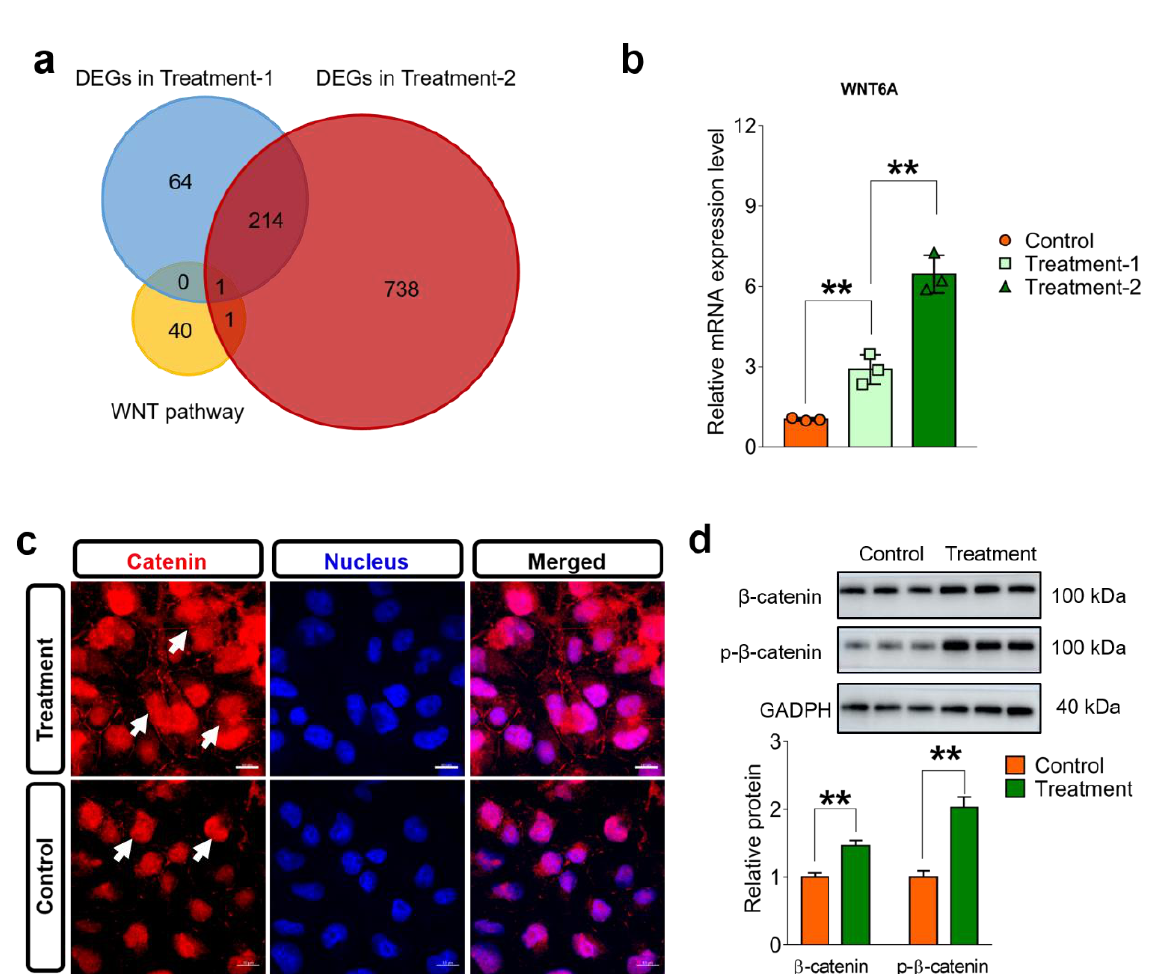
Figure 10. Exposure to 660 nm laser modulates β -catenin-mediated Wnt pathway. ( a ). Venn diagram of Wnt pathway gene set and DEGs depending on different treatment groups. ( b ). Quantification of WNT6 gene post different intervention. Intervention dosages are set as 0.5 and 1.0 J/cm 2 ( n = 3 per group). ( c ). Immunofluorescence staining of catenin protein (red) post treatment ( n = 3 replicates per group). Nucleus was stained using DAPI dye. Intervention dosage is set as 1.0 J/cm 2 . ( d ). Western blot and quantitative measurement analysis of β -catenin and relative phosphorylation levels post intervention ( n = 3 replicates per group). Data are presented as mean ± standard error. One-way analysis of variance (ANOVA) with Tukey’s test, **, p < 0.01.